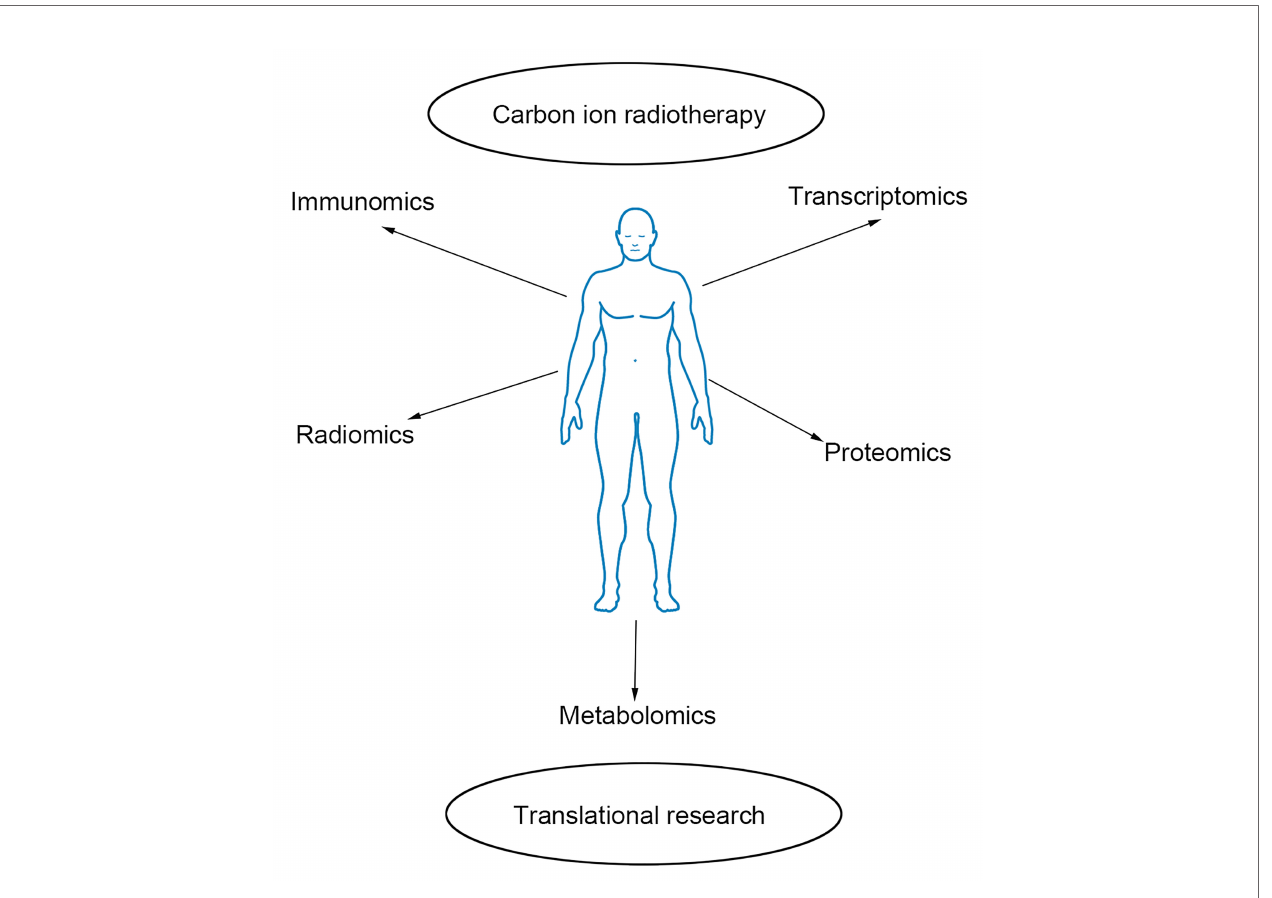
FIGURE 1 | Outline of omics-based translational study. Immunomics, radiomics, transcriptomics, proteomics, and metabolomics are helpful to explore the ef fi cacy and molecular mechanism of prostate cancer with carbon ion